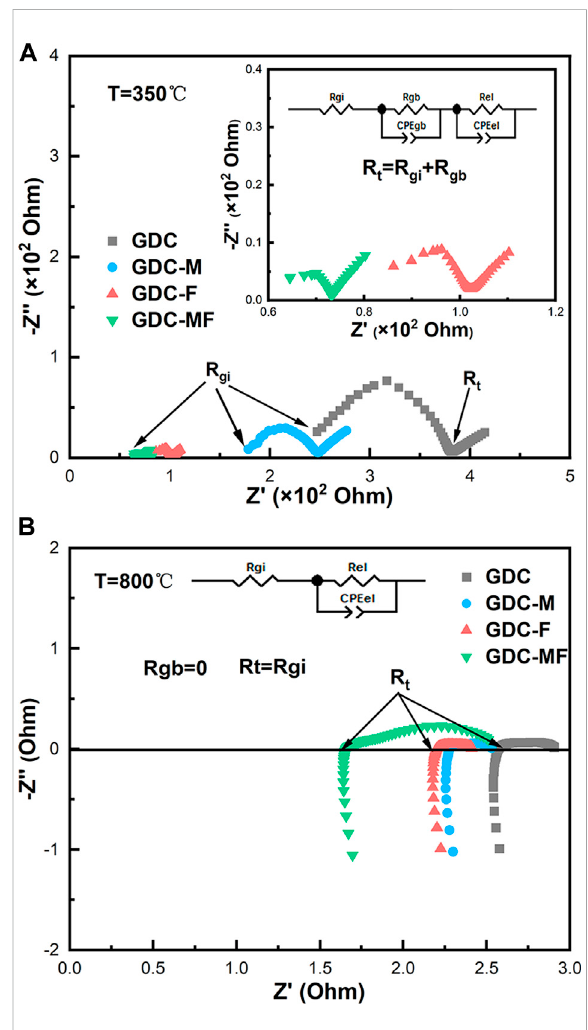
FIGURE 5 EIS analysis of GDC-based electrolytes and Equivalent circuit diagrams at (A) 350 and (B) 800 ° C.